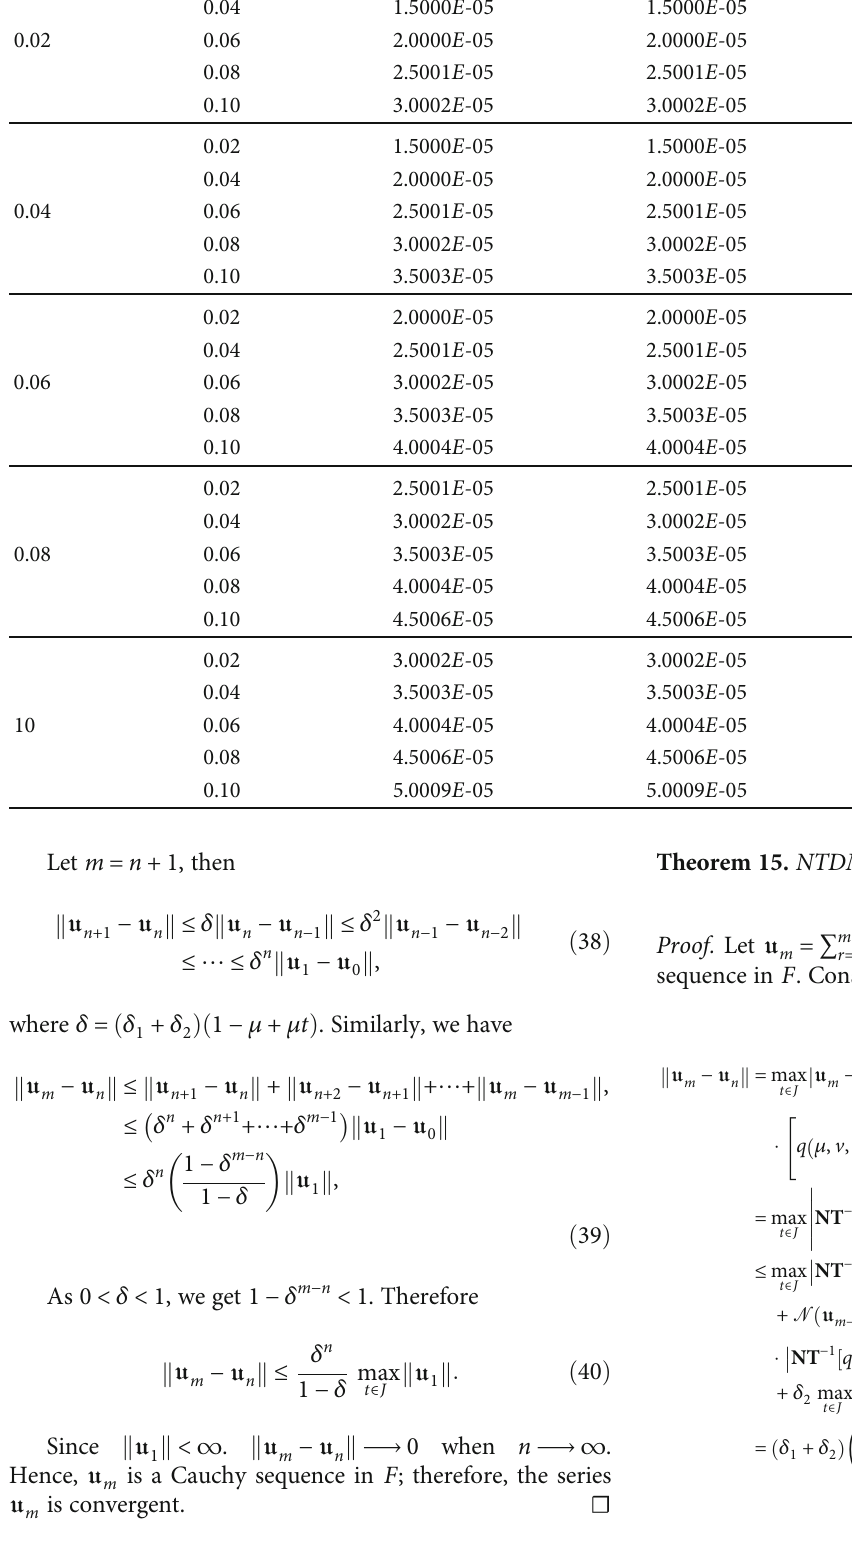
and NTDM for μ = 0 : 67 and μ = 0 : 75 of Example 2 when t = 1 and λ = 0 : 001 . CF ABC μ = 0 : 67 μ = 0 : 75 NTDM